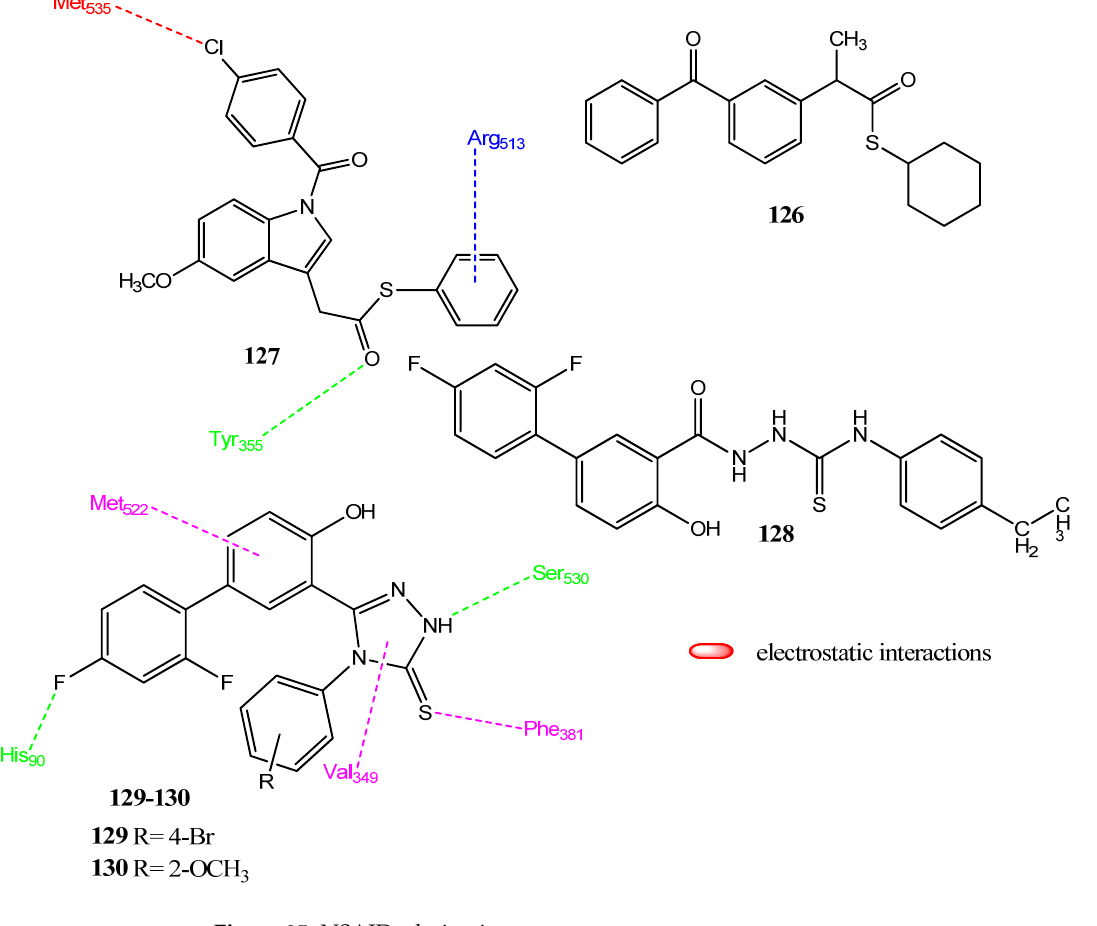
Figure 25. NSAIDs derivatives.